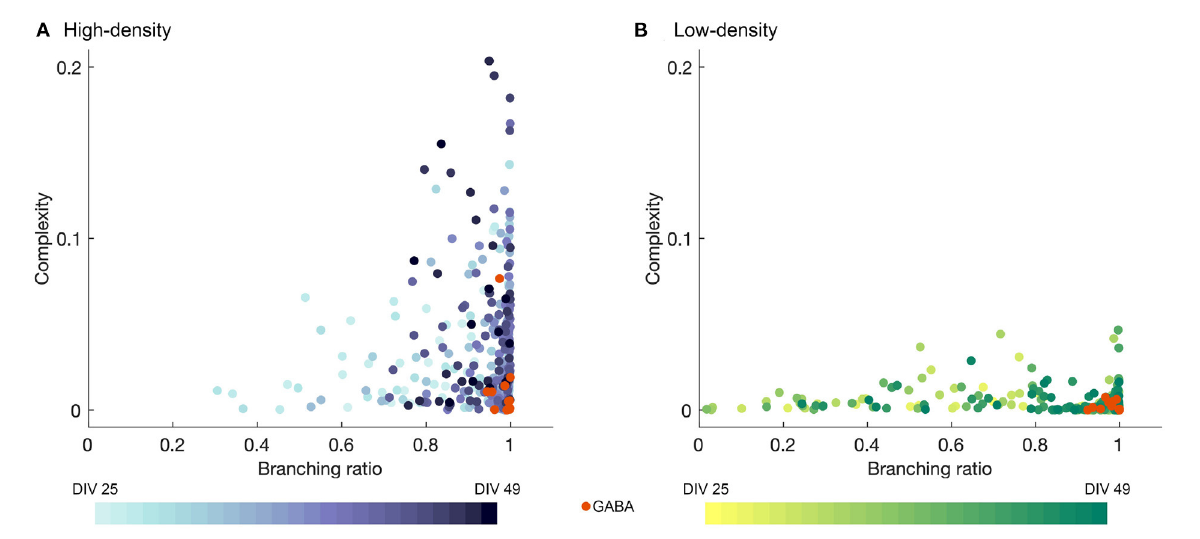
FIGURE6 Complexity plotted against branching ratio for (A) high- and (B) low-density networks, obtained for mid-range time bin sizes ( 1 t = 2,4,8,12,and 16 ms). Darker colors represent later DIVs, and the orange data points represent the activity after the addition of GABA. In (A) , two outliers with branching ratios exceeding 1 ( m = 1.05 and 1.08) were removed for the sake of